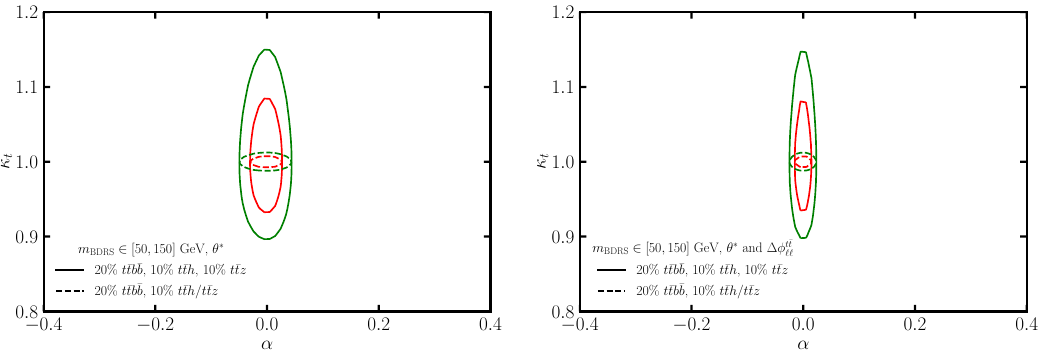
Figure 10 . 68% (red) and 95% (green) CL limits on the α - κ t plane for the 100 TeV FCC with 30 ab − 1 without (left) and with (right) ∆ φ t ¯ t . For the solid curves, 10% systematics is used for both ‘‘ t ¯ th and t ¯ tZ individually, while for the dashed curves, the uncertainties for t ¯ th and t ¯ tZ are assumed to be correlated. 20% systematics is used for t ¯ tb ¯ b for both